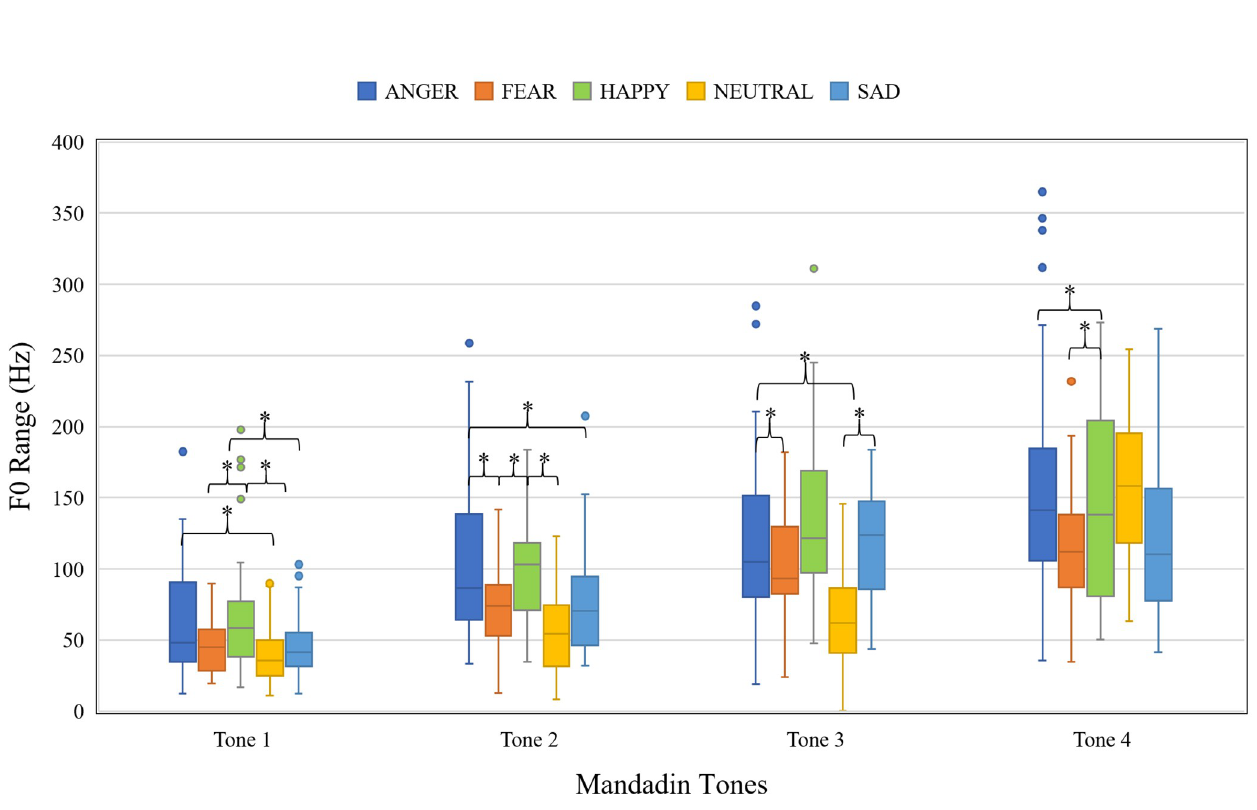
Fig 3. Boxplot showing the F0 range of target syllables as a function of Mandarin tone and emotion. ( * p < .05).